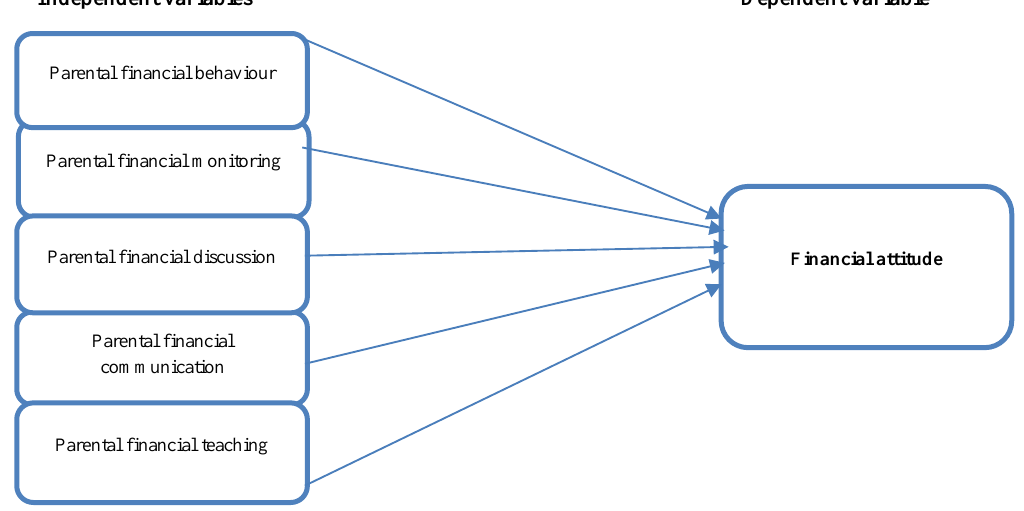
Figure 1: Conceptual model of the study, Source :